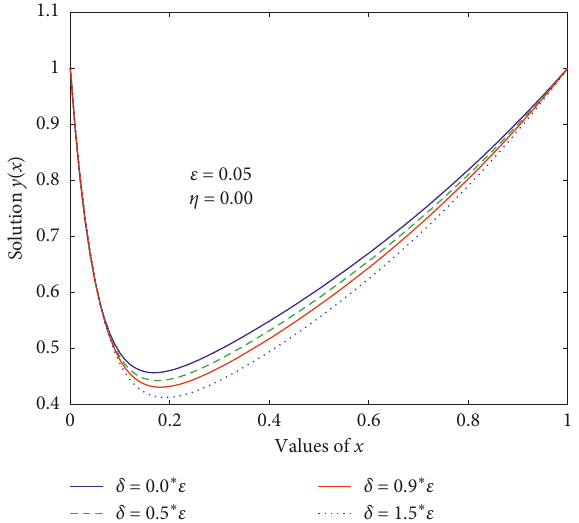
Figure 2: Approximate solution of Example 2 for different values of δ .